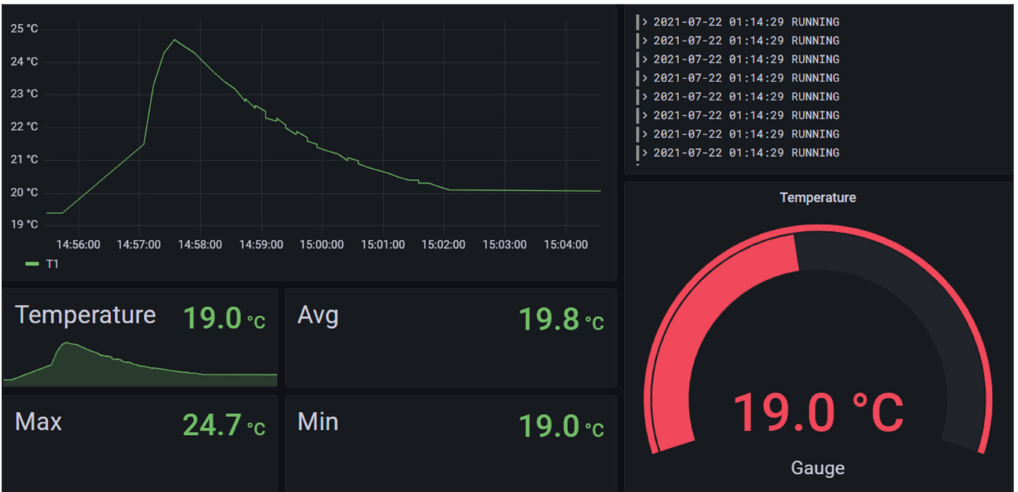
Figure 15. Grafana dashboard for the visualisation of sensor